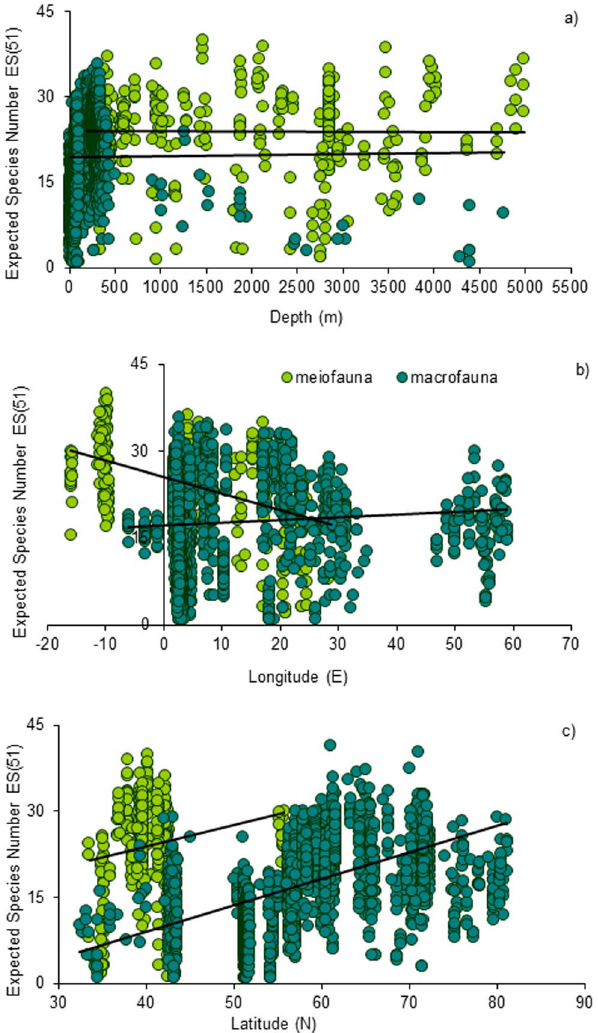
diversity as ES(51). Reported are A) bathymetric gradient, B) longitudinal and C) latitudinal. The equations of the fitting lines are: y = 2 5e 2 05 6 + 24.1 (n = 306, R 2 = 7e 2 0.5 , ns for meiofauna, y=0.0002 6 + 19.4 (n=2226, R 2 =7e 2 05 , ns for macrofauna along the bathymetric gradient; y= 2 0.29 6 + 25.5 (n=306, R 2 =0.18, p , 0.01) for meiofauna, y=0.05 6 + 17.15(n=2789, R 2 =0.07, ns) for macrofauna along the longitudinal gradient; y=0.37 6 + 8.9 (n=306, R 2 =0.04, ns) for meiofauna, y= 0.46 6 2 9.3 (n= 2821, R 2 = 0.30, p , 0.01) for macrofauna along the latitudinal gradient (sources for